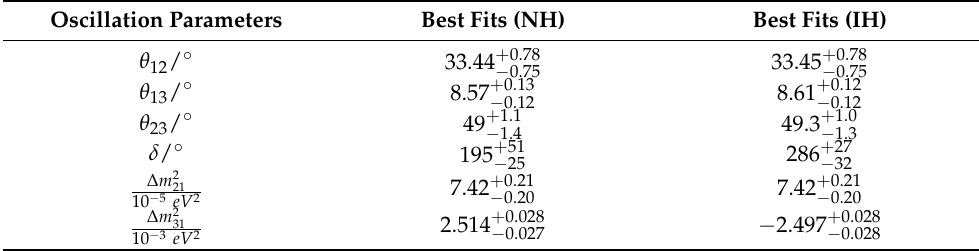
Table 3. Best fits for oscillation parameters obtained by the global analysis in